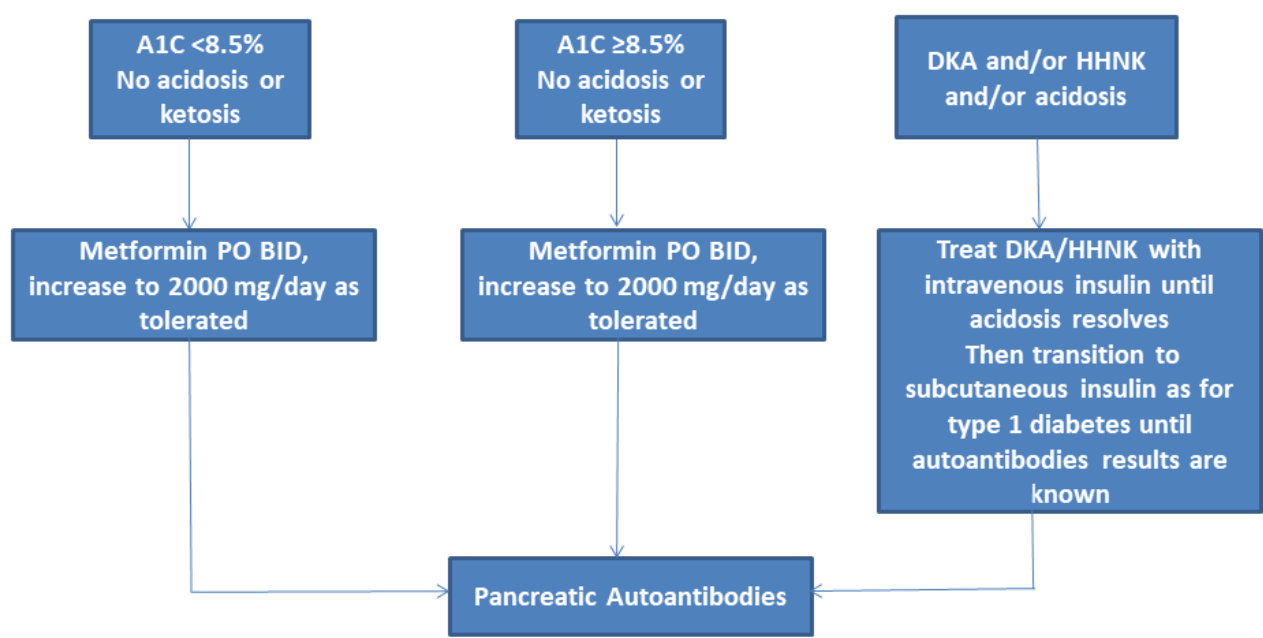
Figure 1. Initial management of new onset diabetes in youth with overweight or obesity. DKA, diabetic ketoacidosis; HHNK, hyperosmolar hyperglycemic nonketotic syndrome. Adapted from American Diabetes, A., 13. Children and Adolescents: Standards of Medical Care in Diabetes-2020. Diabetes Care 2020 , 43 (Suppl. 1),